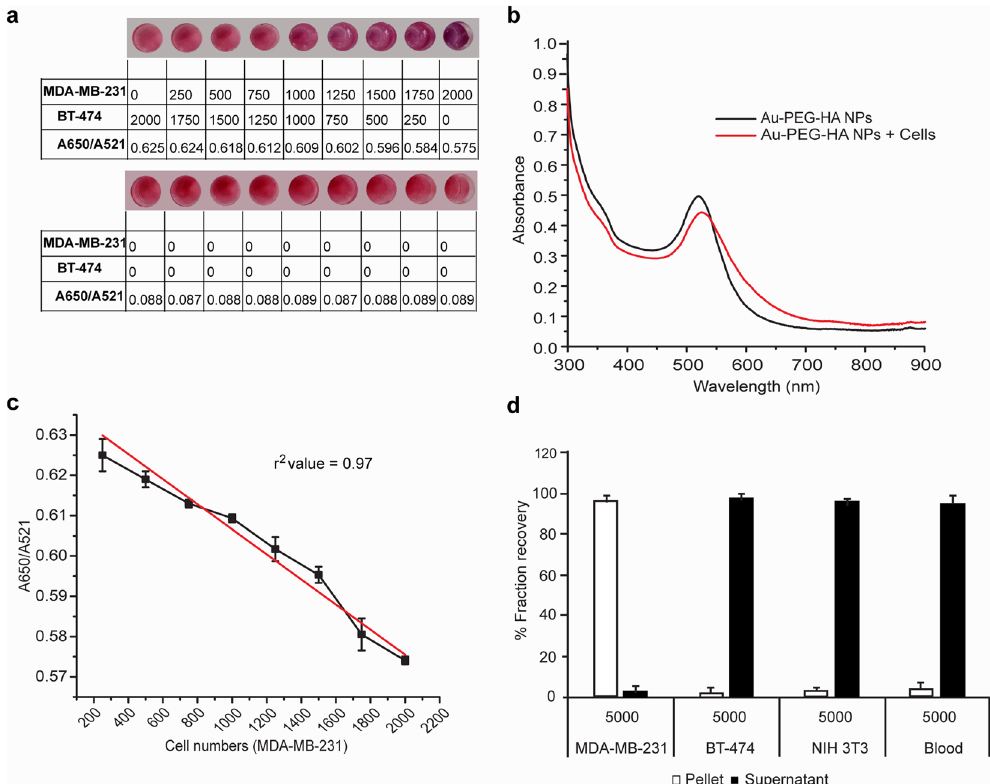
Figure 4. Exploiting CD44-HA interaction for detecting cells of interest (MDA-MB-231) from a heterogeneous population. ( a,b ) Cell mixtures were prepared by mixing MDA-MB-231 (CD44 + ve/high ) and BT-474 cells (CD44 − ve/low ) in varying ratios, but keeping the total number of cells constant (2000). 100 µ l of Au-PEG-HA NPs solution (25 nM Au and 100 µ g/ml HA) was added to each well, followed by 10 min incubation at room temperature. The colorimetric changes (with A650/A521 ratio) ( a ) and UV-Vis absorption spectra ( b ) were recorded and compared with control (Au-PEG-HA NPs) values. ( c ) Variation in A650/A521 ratio of Au- PEG-HA NPs after incubation with cell mixture with respect to target cell population (MDA-MB-231). ( d ) Flow cytometric analysis of cells isolated from AU-PEG-HA NPs using differential